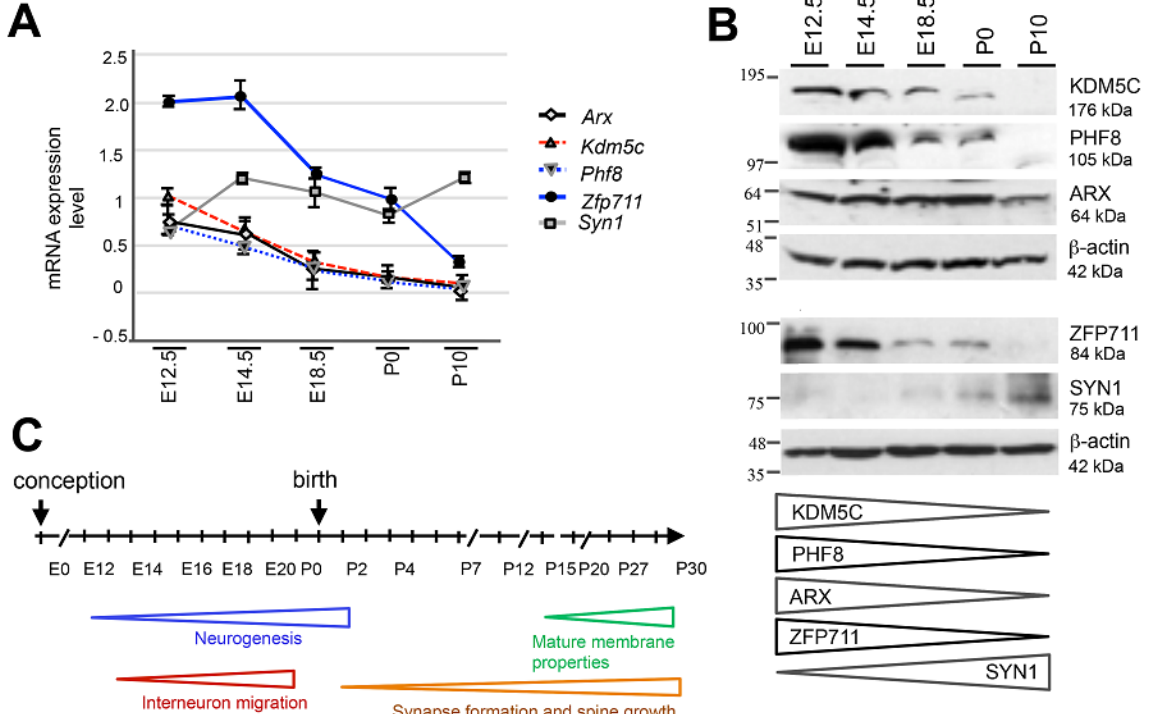
Figure 2. Expression profiles of Kdm5c , Arx , Phf8 and Zfp711 in embryonic and neonatal mouse brain. Representative quantitative real-time PCR ( A ) and western blot analysis ( B ) of Arx /ARX, Phf8 /PHF8, Kdm5c /KDM5C, Syn1 /SYN1 and Zfp711 /ZFP711, throughout prenatal and postnatal stages in the whole WT murine brain. The transcript analysis was performed in triplicate and the samples were normalized to 18S . The bars indicate the mean ± standard error of three independent experiments. The Western blotting experiment was repeated three times. The beta-actin antibody ( β -actin) was used as a loading control. ( C ) Schematic representation of the neuronal developmental time line (days) from conception to birth and from birth until 30 days after birth